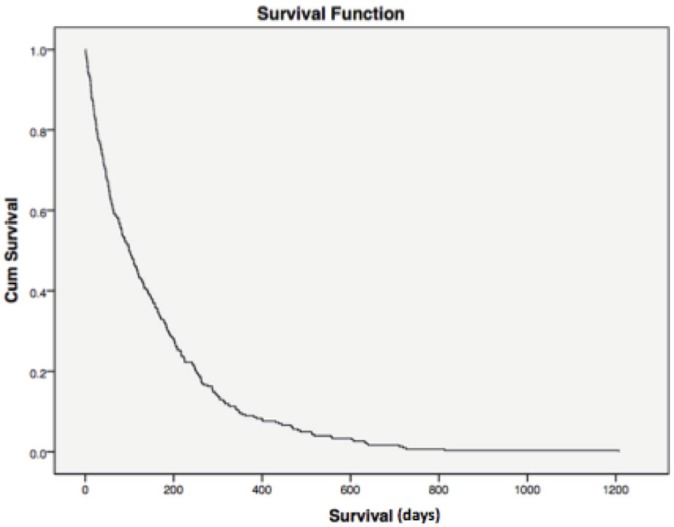
Overall survival. For all patients, median overall survival was 99 days (1–1207), demonstrating the poor prognosis of this population of poor-PS patients overall. Cum = cumulative.